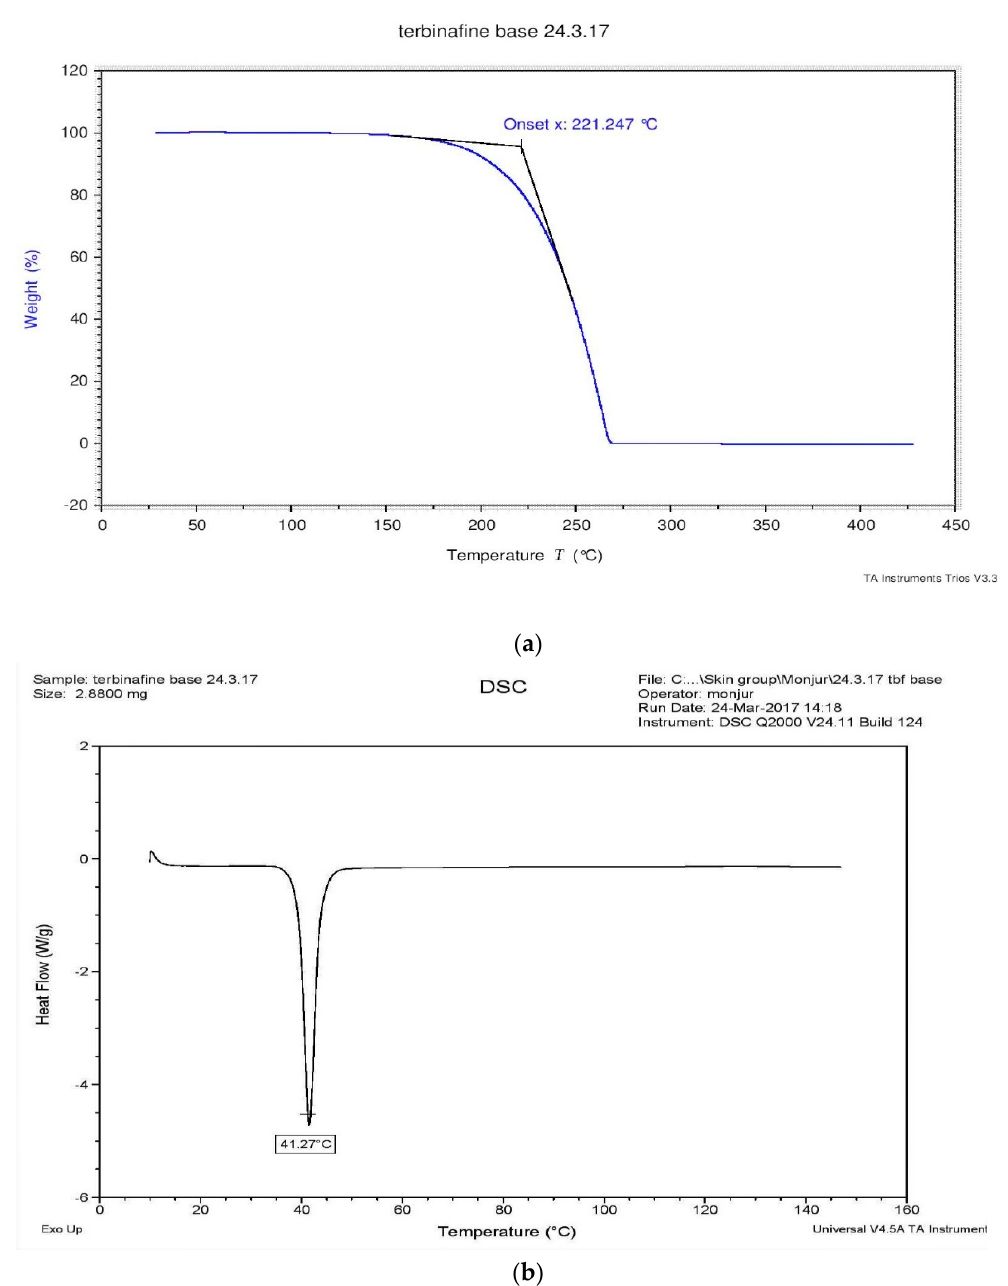
Figure 3. TGA ( a ) and DSC ( b ) analysis of TBF-free base.